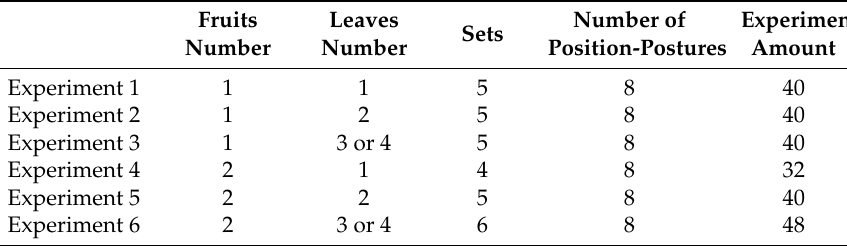
Figure 12. Experiment with two fruits and one leaf. Table 3. Experiment plans for different fruit-leaf